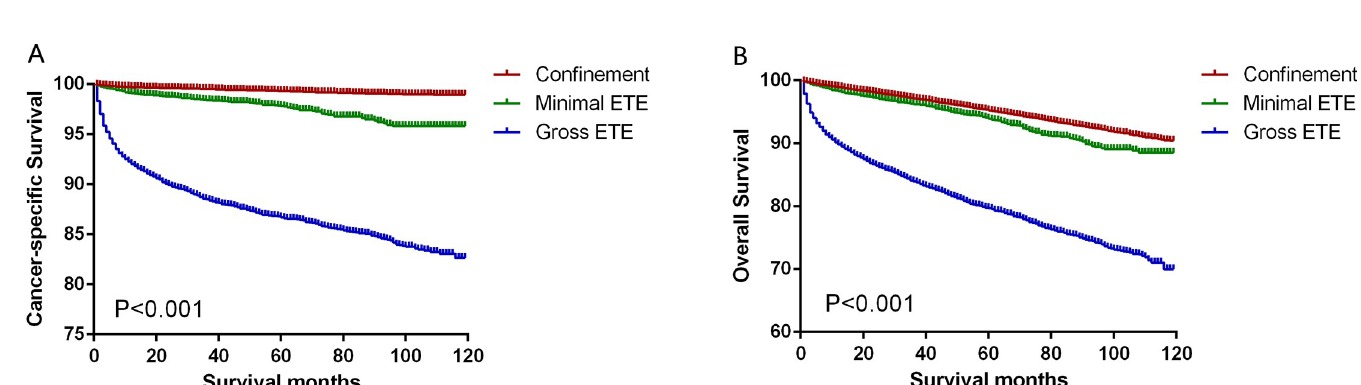
PLOS ONE | https://doi.org/10.1371/journal.pone.0218171 June 14,